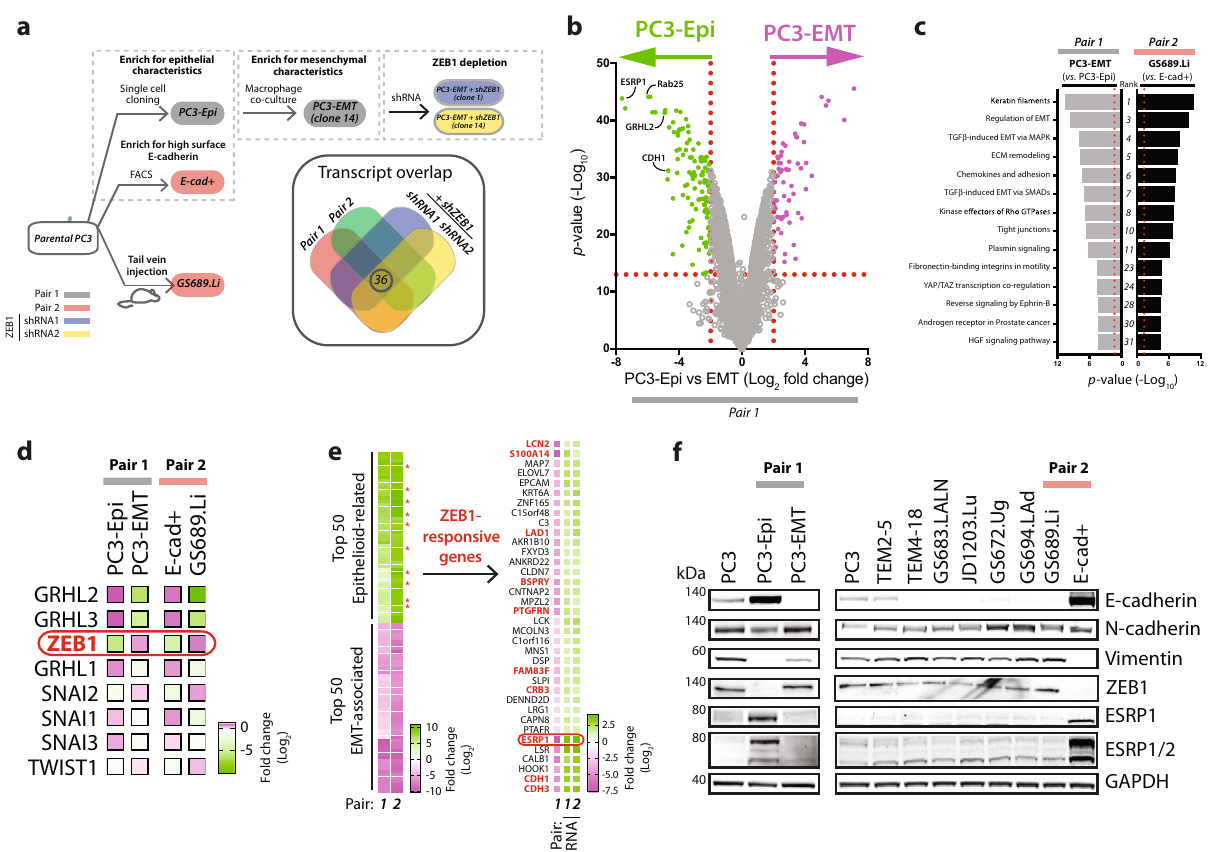
Fig. 4 | Deconvolution of molecular pathways underpinning different pheno- types.a SchemaofPC3sublinepairs.Pair1isPC3selectedforepithelialshape(PC3- Epi)thenmadetoundergo EMTbyco-culturewith macrophages(PC3-EMT).Pair2 is PC3 FACS sorted for high surface E-cadherin (E-cad+) vs PC3 harvested from a liver metastasis following in vivo selection (GS689.Li). Two PC3-EMT lines stably expressing ZEB1 shRNAs were also examined to identify ZEB1-in fl uenced tran-